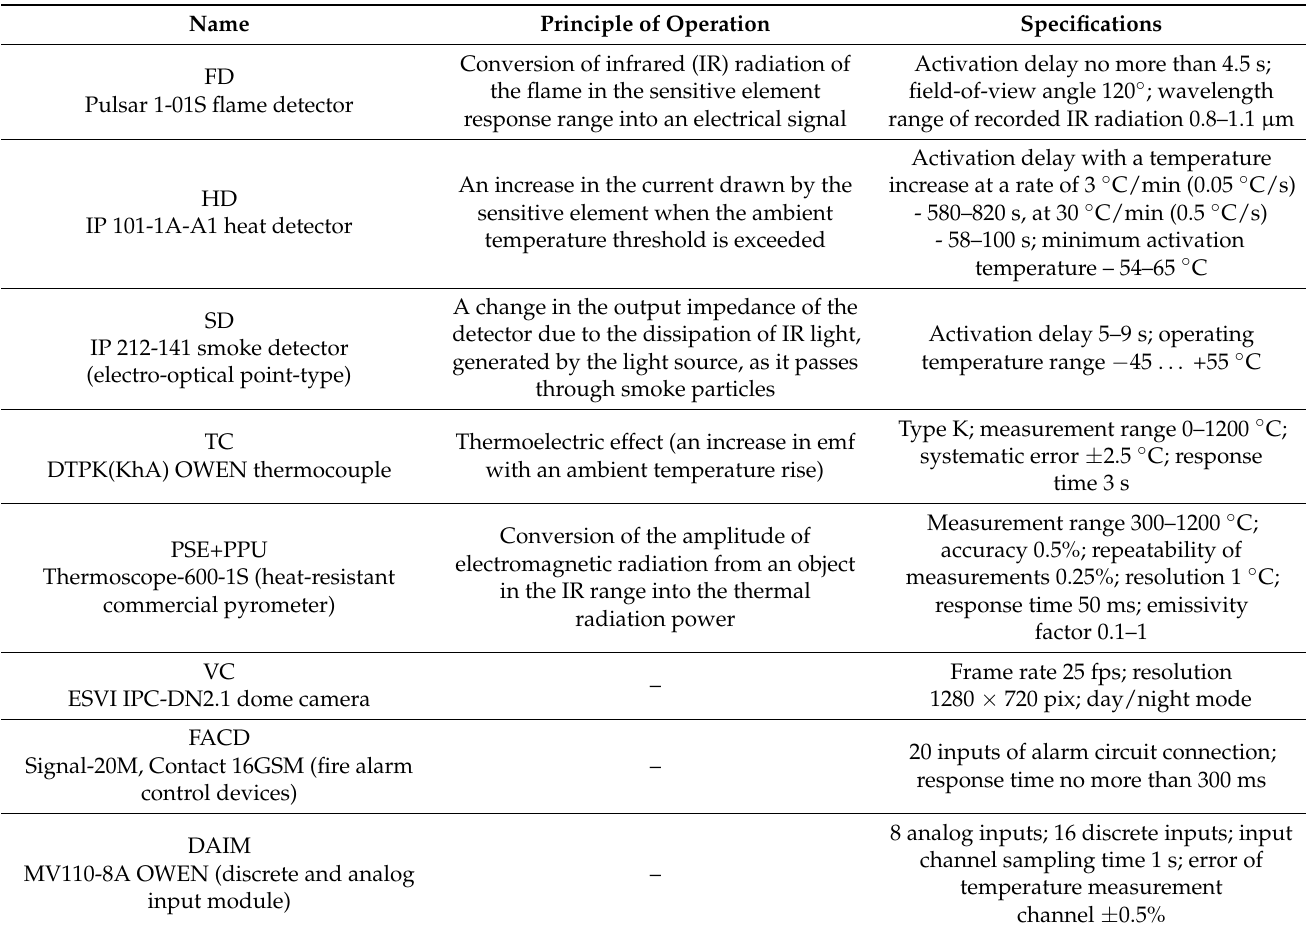
Table 1. Characteristics of sensors and devices used in the experiments (FD, HD, SD, TC, GDS, PSE+PPU, VC, FACD,